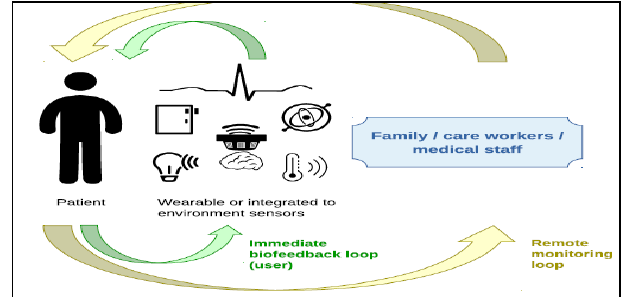
Figure 3: Smart Environment for